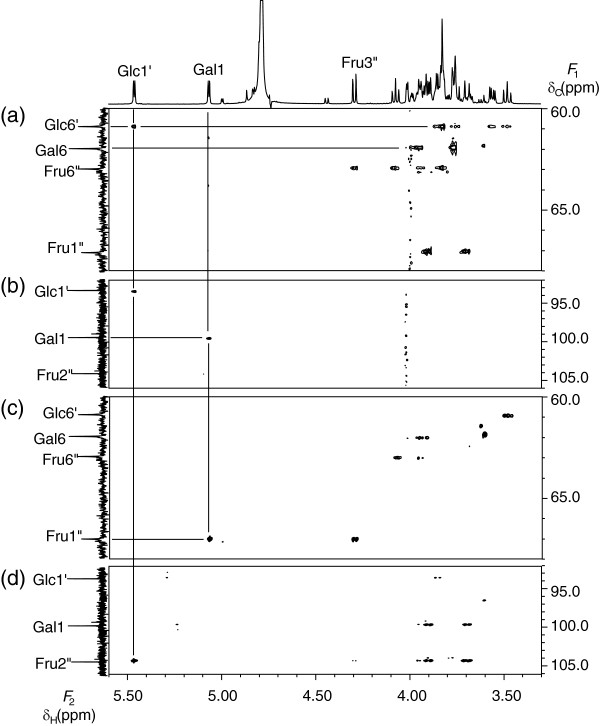
Selected parts of the HSQC-TOCSY (a), HSQC (b), HMBC (δC60.0 ppm ~ 68.0 ppm ) (c), and HMBC (δC92.0 ppm ~ 106.0 ppm) (d) spectra of saccharide 2.